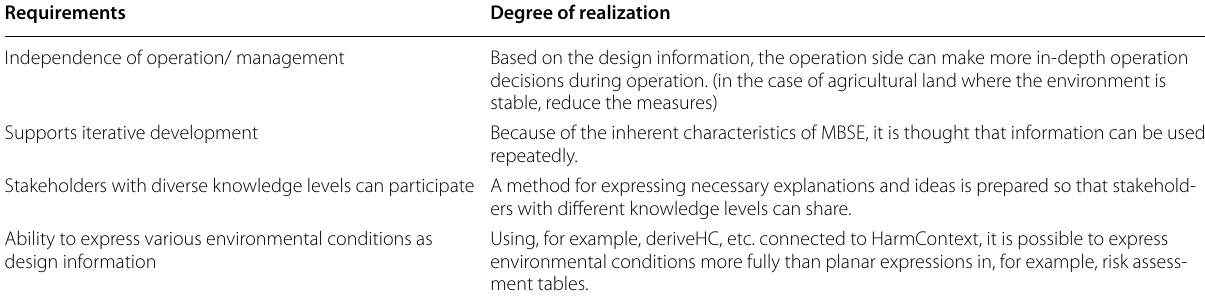
Table 4 Realization of requirements for agricultural robots Requirements